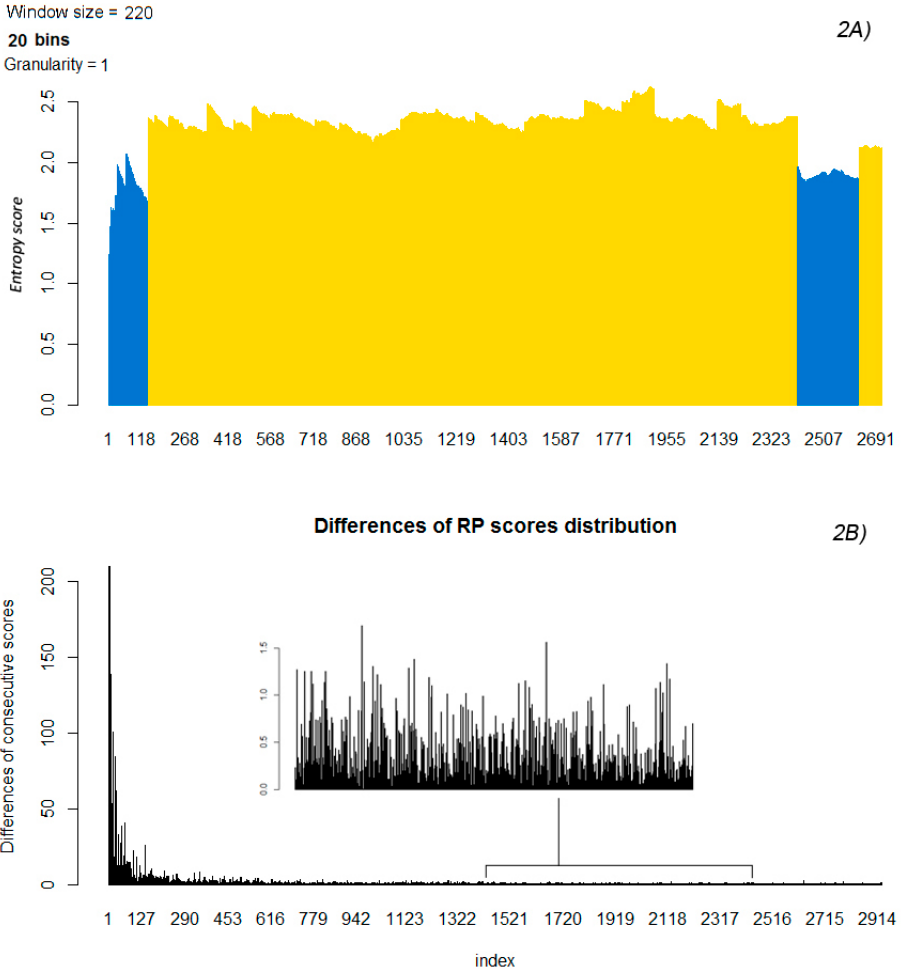
Figure 2. ( A ) Characteristic entropy distribution for GSE60767 data, winter 2009, upregulated. Parameters used were: window size 220, 20 bins for discretization and advancement of the sliding window gene-by-gene. The initial, low-entropy set is clearly defined (initial blue-colored area). The low-entropy area near the end is attributed to a single difference value oscillation, lowering the entropy of the 220 windows containing it. ( B ) The corresponding distribution of consecutive RP score differences. The initial, signal-dominated area always overlaps with genes selected by the original rank products. The latter, noise-dominated area represents features to be excluded.